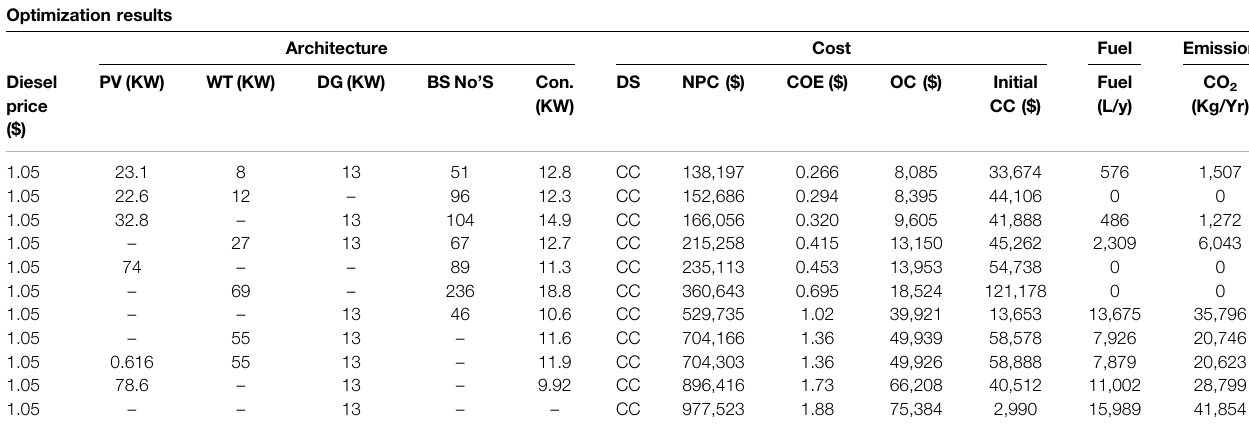
TABLE 12 | HOMER optimization results of the PV/Wind/Diesel/Battery system for Thoothukudi. Optimization results